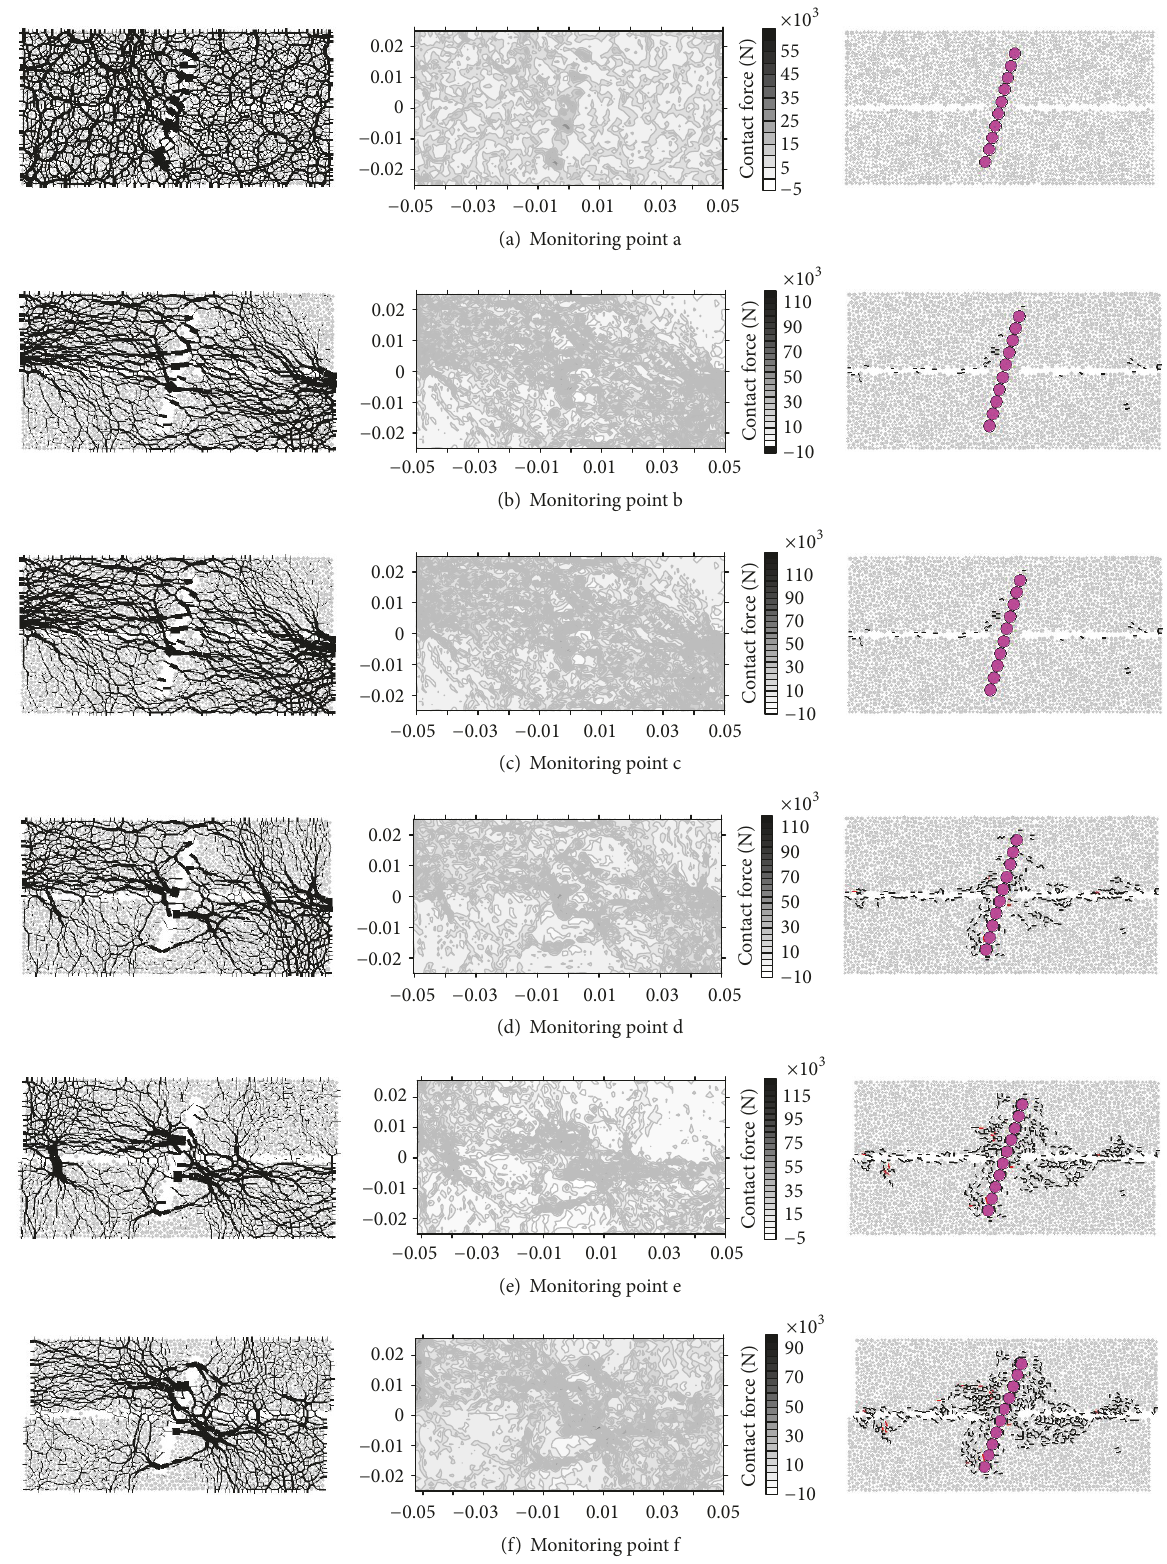
Figure 14: Evolution of the contact force and cracking at different monitoring